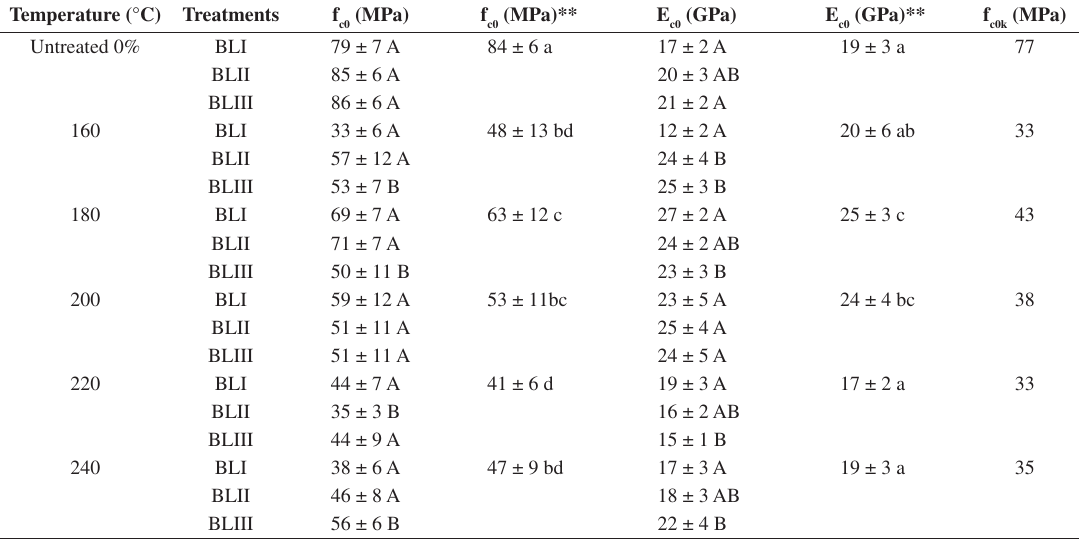
Table 2. Strength and stiffness properties, and characteristic values of the compression. Temperature (°C)